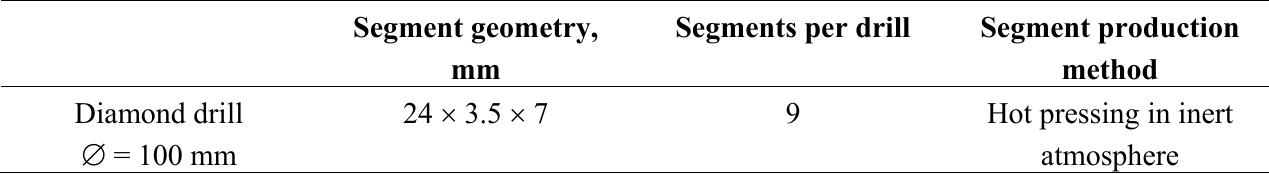
Table 3. Parameters of diamond